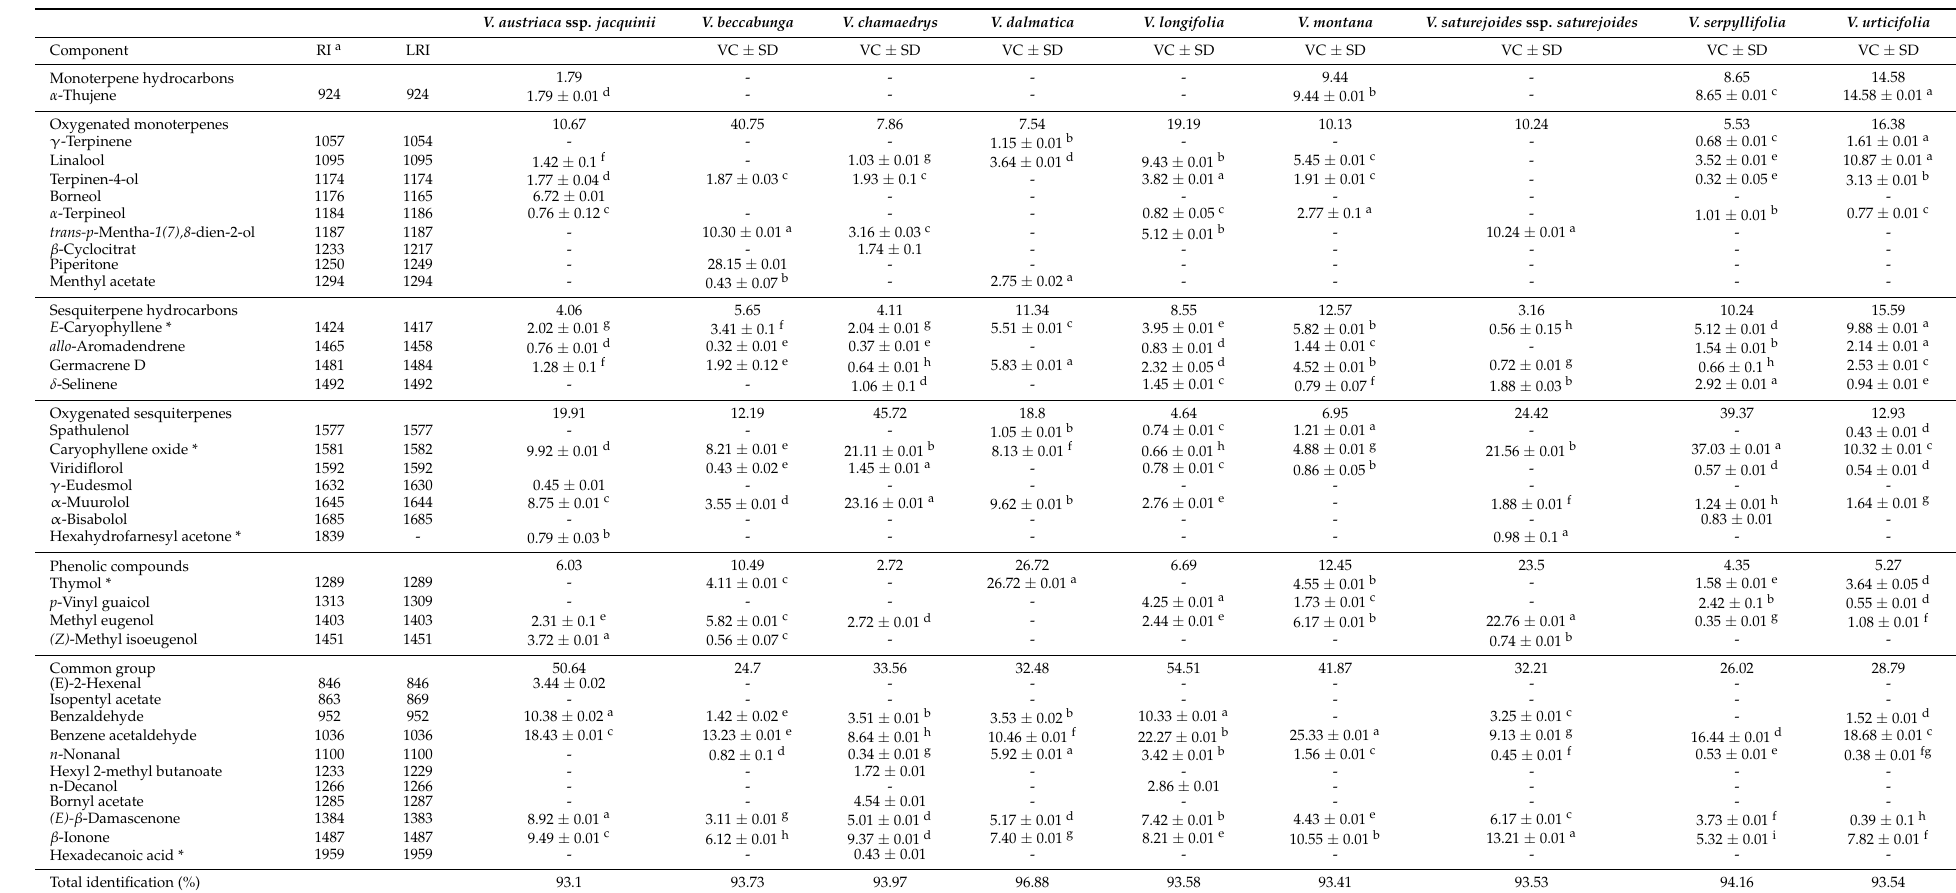
Table 2. Components of the hydrosols (%) obtained by hydro-distillation from the aerial parts of Veronica